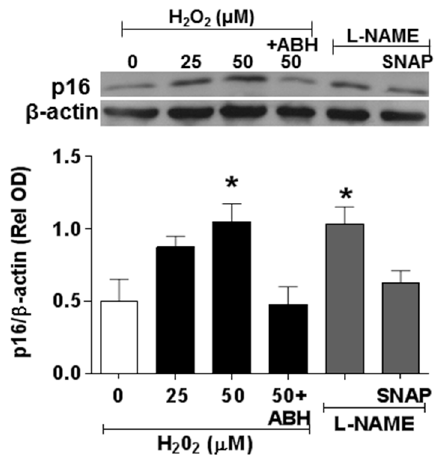
Figure 10. Hydrogen peroxide induces an increase in the cyclin-dependent kinase inhibitor p16INK4a. Western blot and quantitation showing effects of treatment with hydrogen peroxide or L -NAME in increasing expression of p16INK4a protein. These effects were blocked by the arginase inhibitor ABH (100 µ M) or the NO donor SNAP (10 µ M), * p < 0.05 vs. control, n = 3–4.